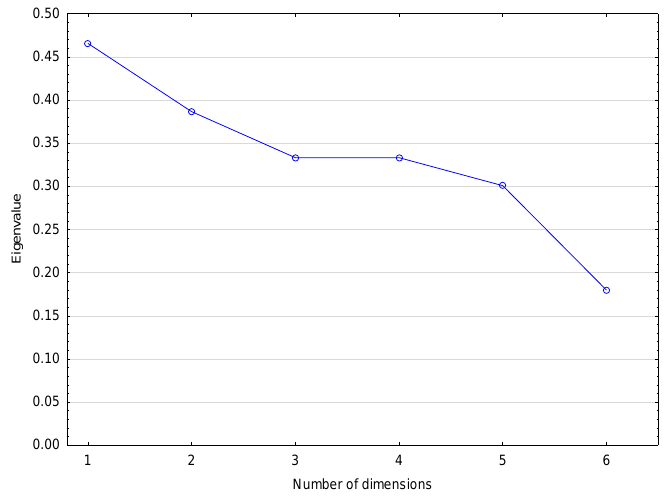
Figure 4. Plot for multidimensional correspondence analysis.